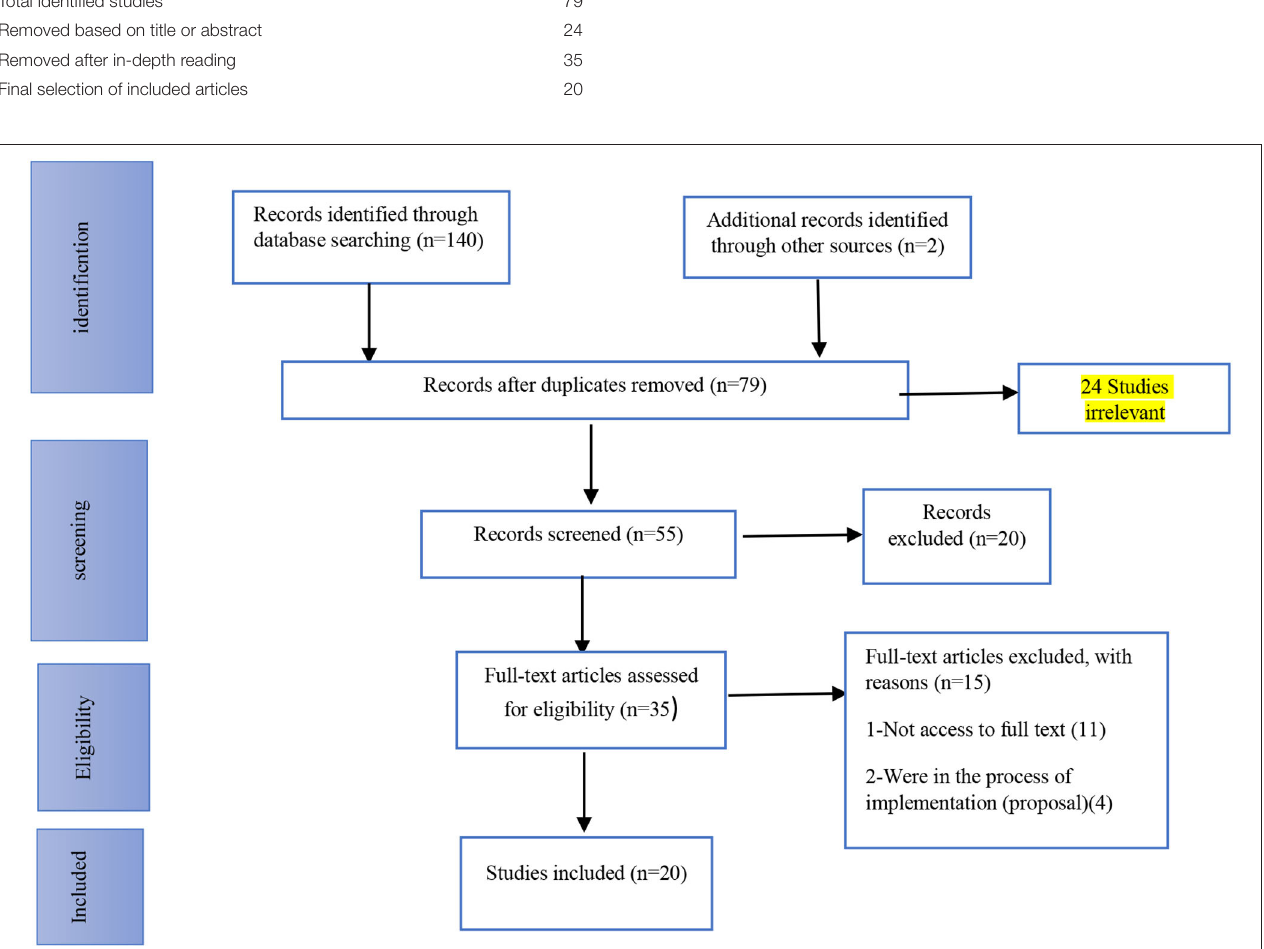
FIGURE 1 | PRISMA flowchart for search strategy and results.